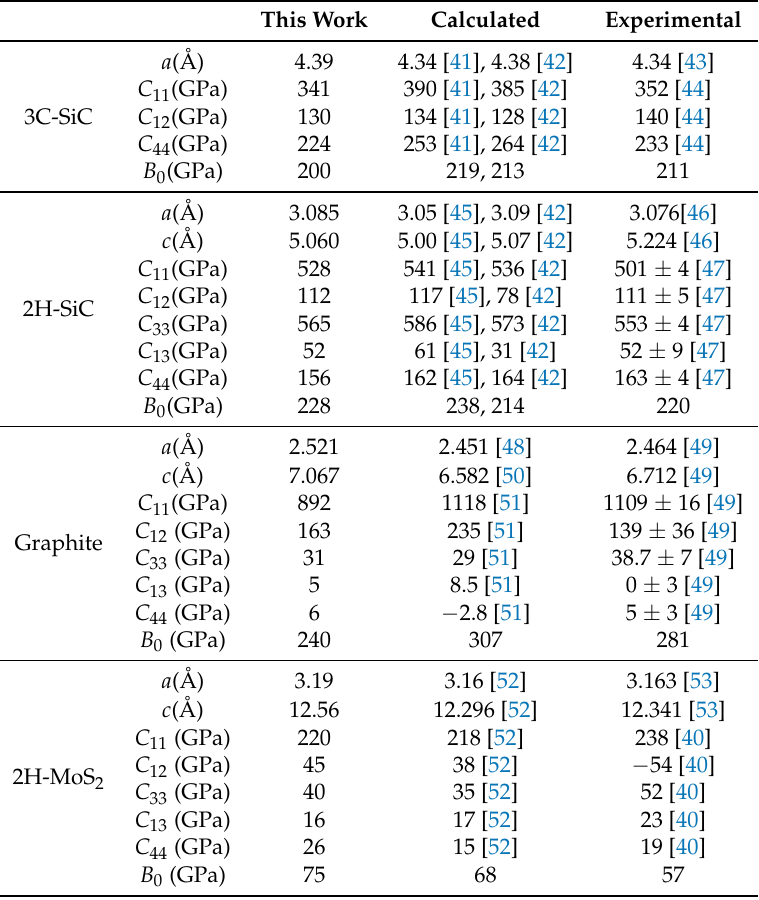
Table 2. Zero pressure lattice and elastic constants of 3C- and 2H-SiC polytypes, graphite and 2H-MoS 2 . All B 0 values calculated using Voigt elastic constants